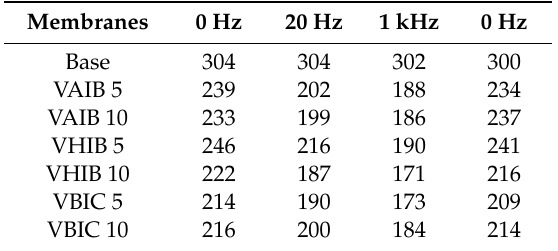
Table 3. The molecular weight cuto ff (in kDa) for responsive membranes in presence of oscillating electric field of di ff erent frequency.